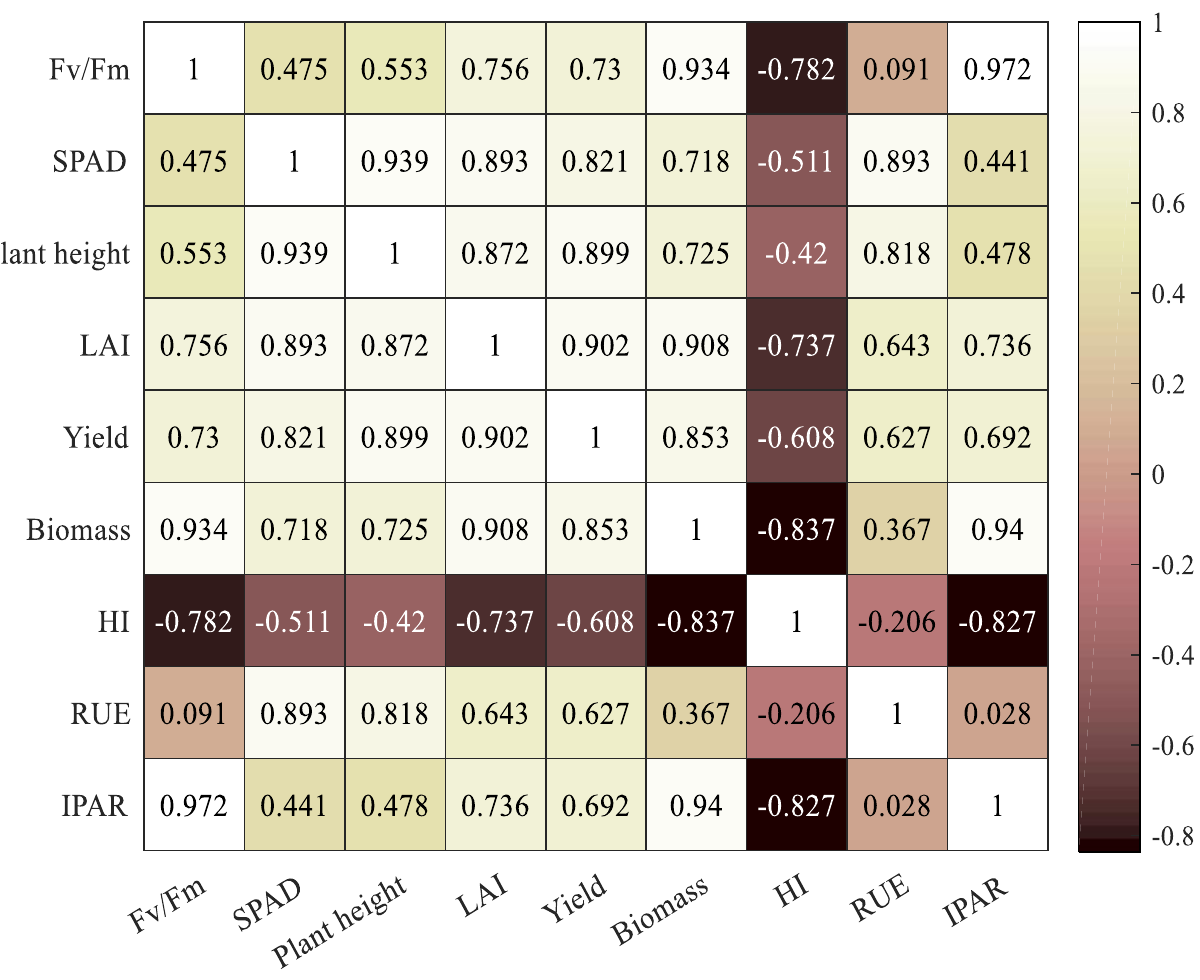
Figure 5. Evaluation index correlation matrix. Note: F v /F m represents the photosynthetic efficiency of PSII; SPAD represents the relative leaf chlorophyll content; LAI represents the leaf area index; HI represents the harvest index; RUE represents the radiation use efficiency, and IPAR represents the amount of intercepted photosynthetically active radiation.